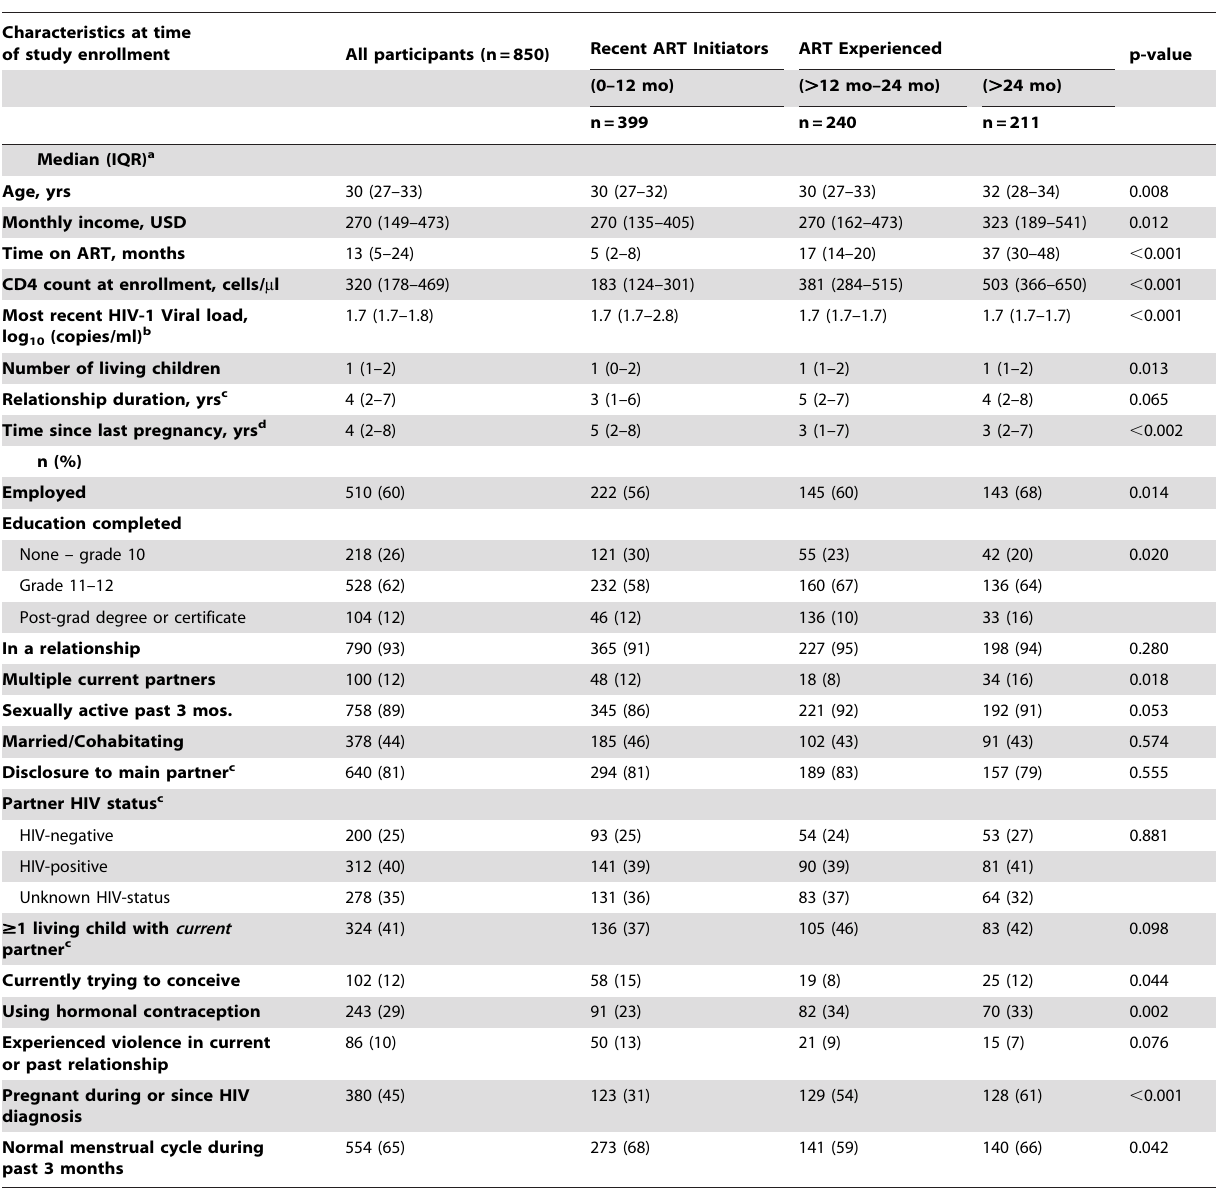
Table 1. Description of baseline cohort characteristics by months-on-antiretroviral therapy (ART), South Africa.